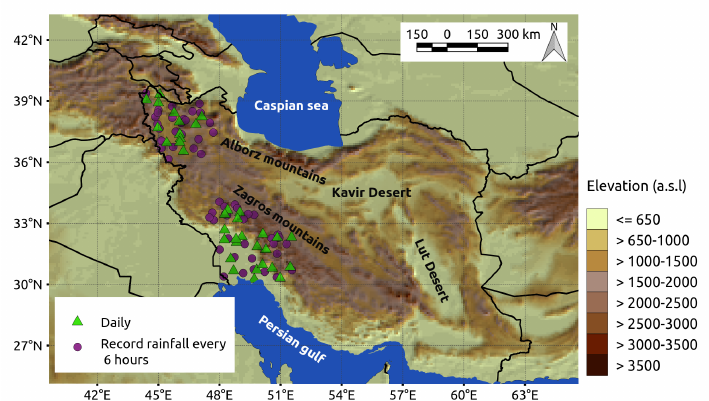
Figure 2. Distribution of available rainfall gauge stations in the study